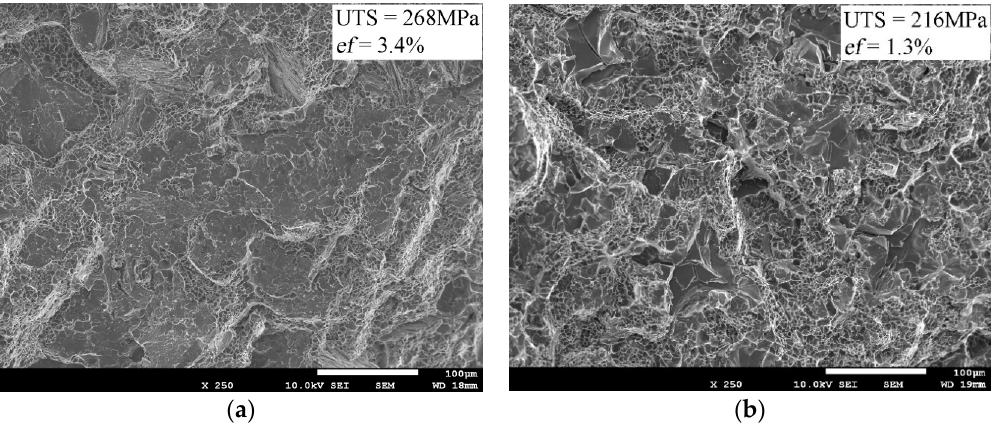
Figure 6. Overview images of fracture surfaces of ( a ) alloy A SDAS 25 and ( b ) alloy D SDAS 25.